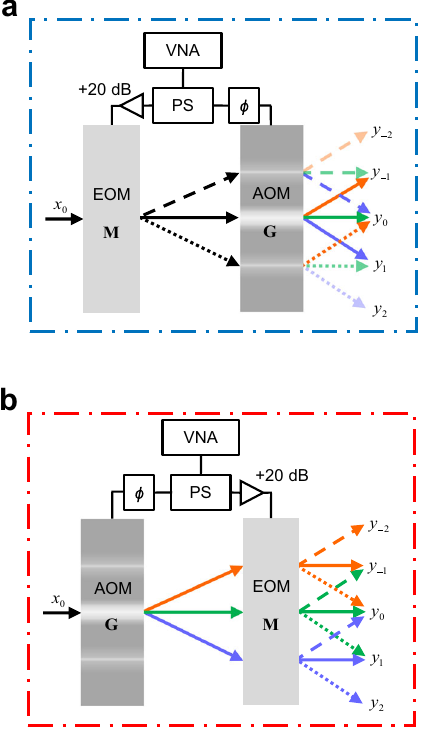
Fig.4|Concatenationsofphasemodulators.a Setupofconcatenatedbroadband electro-optic phase modulator (EOM, M ) and our device (AOM, G ) driven by the same vector network analyzer (VNA). A laser input at Δ =0 ( x 0 ) goes through the EOM fi rst and then the AOM, G ∙ M ∙ x 0 . b Setup of the concatenation in the reverse order, M ∙ G ∙ x 0 .Orange,greenandbluelinesrepresentthe − 1st,0th(carrier)and1st harmonic signals generated by the AOM. Solid, dotted and dashed lines represent